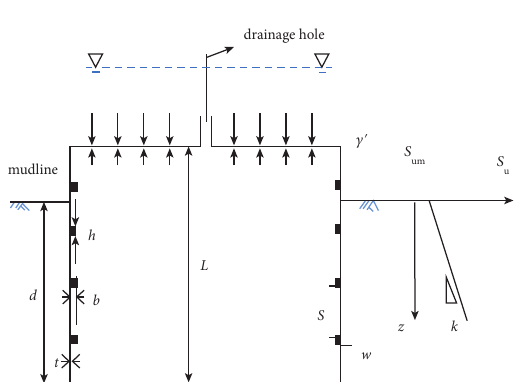
Figure 2: Geometry of square stiffened